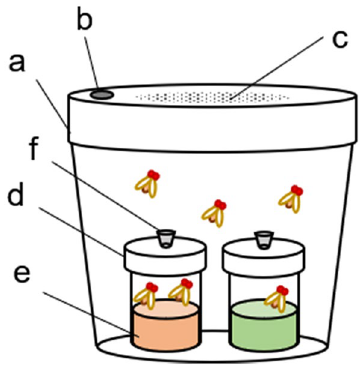
Figure 2. Test apparatus for olfactory response tests (trap assays). ( a ) 500 ml plastic container. ( b ) Opening (8 mm in diameter) for the rapid transfer of flies. ( c ) Fifty tiny ventilation holes. ( d ) Glass vial. ( e ) Odour source sample. ( f ) Tube made of a pipette tip inserted into a hole (2 mm in